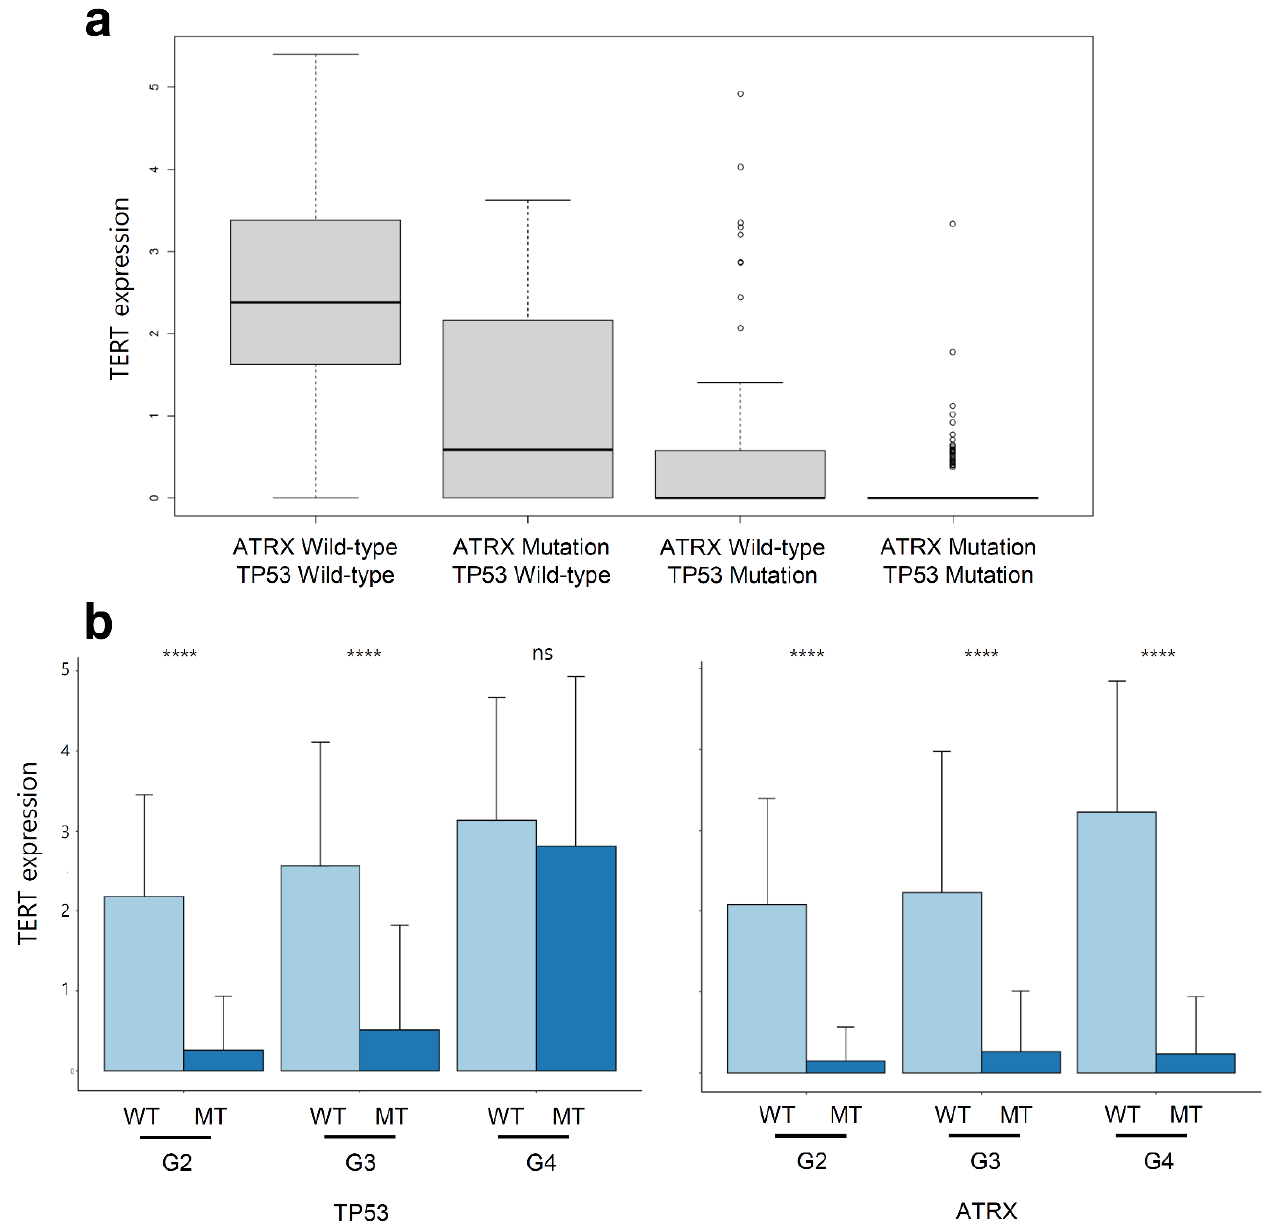
Figure 6. Variation in TERT expression level with the mutation statuses of ATRX and TP53 in tumours with IDH1 mutation ( a ). TERT expression level in tumours with IDH1 mutation with separated mutation statuses of ATRX and TP53 for each grade. WT indicates wild-type; MT indicates mutation. p -values < 0.0001 are shown as ****. ns is not significant ( b ).